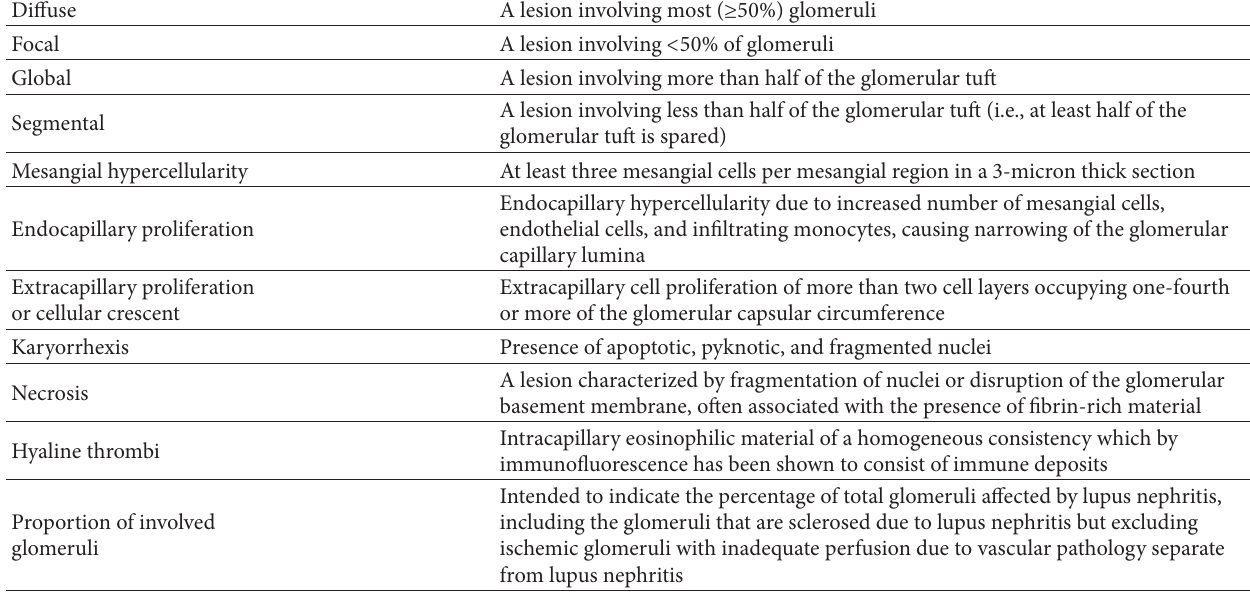
Table 1: Definitions for diagnostic terms according to the 2004 ISN/RPS lupus nephritis classification.